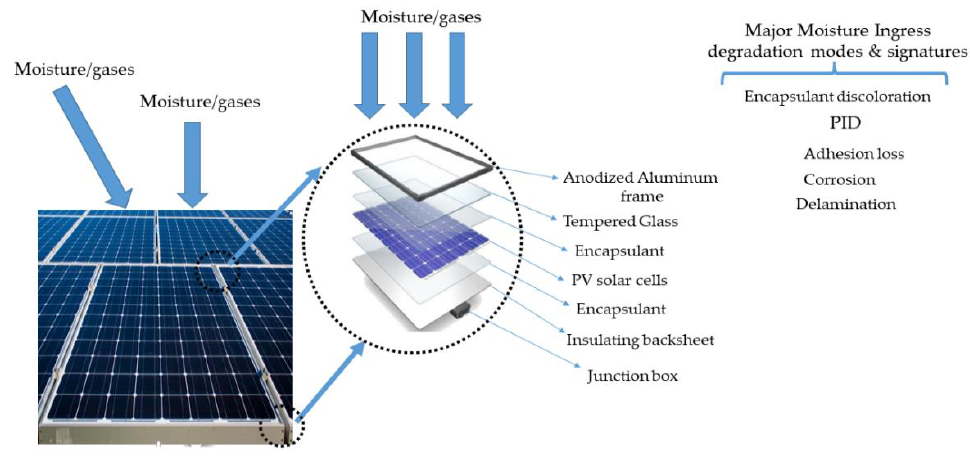
Figure 3. Typical degradation modes and signatures associated with moisture ingress [31].